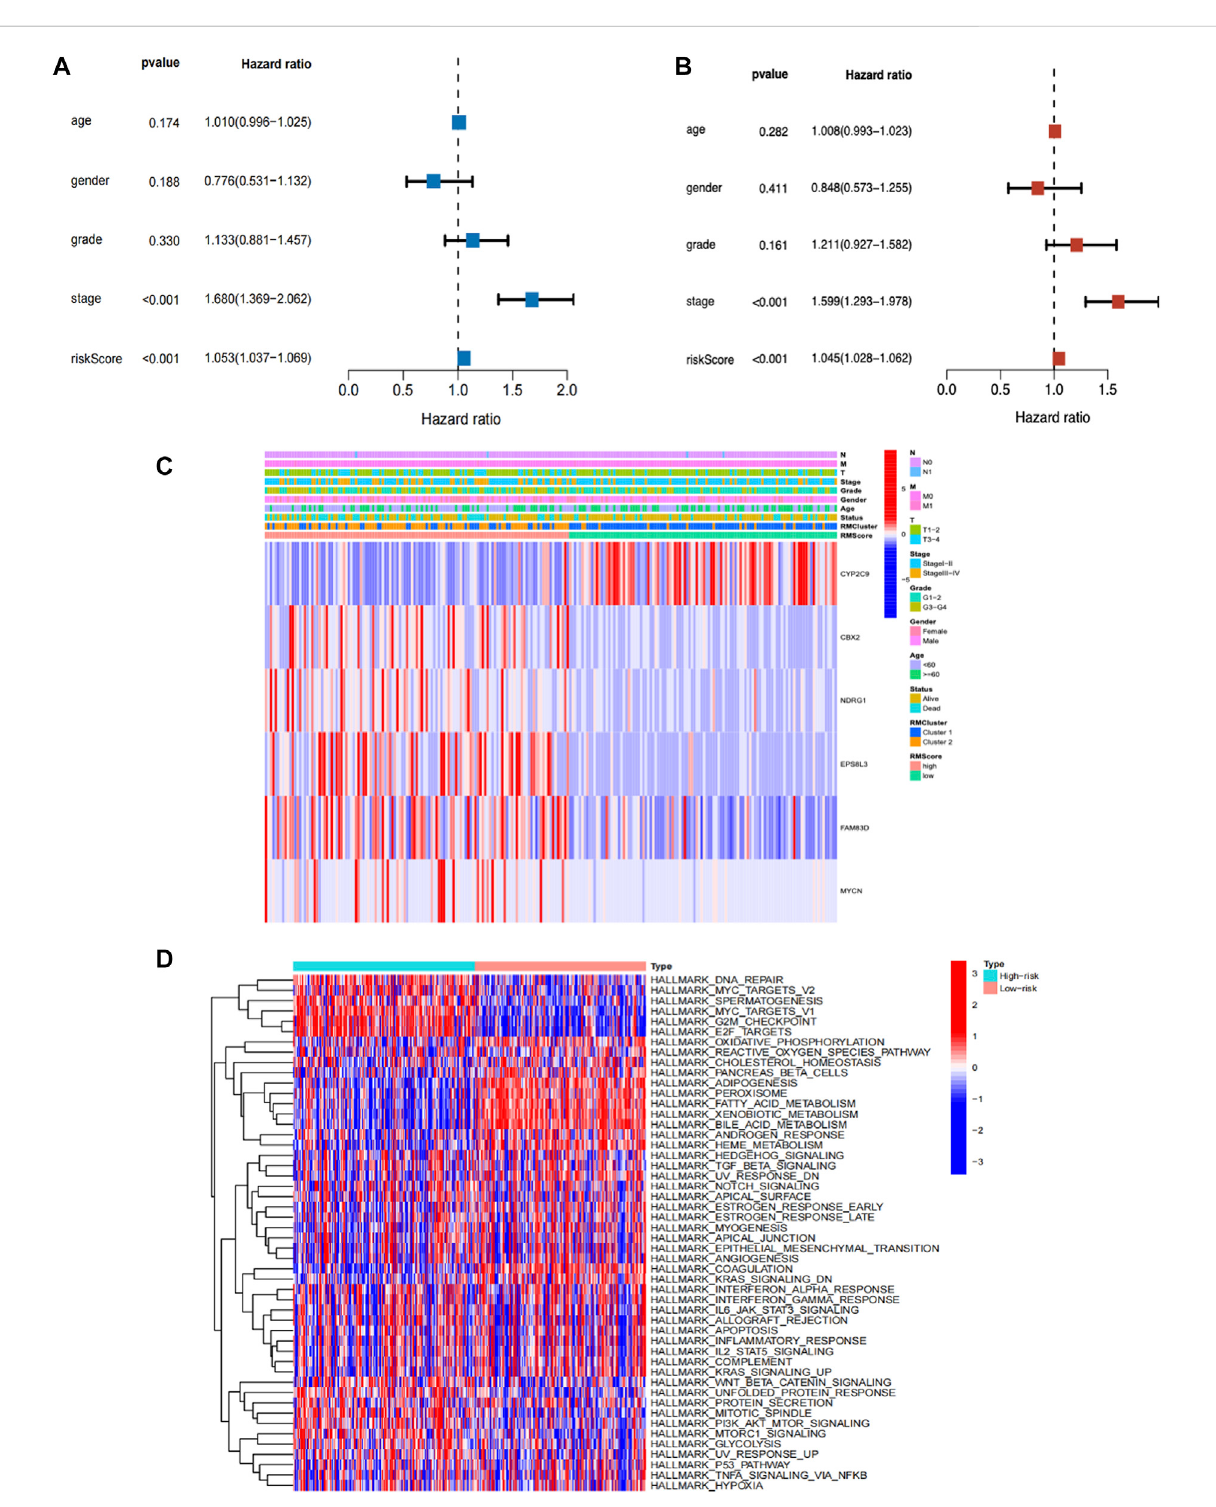
FIGURE 4 (A) Univariate Cox regression analysis and (B) multivariate Cox regression analysis verifying independent prognostic value of RMScore for the prognosis of HCC patients. (C) Heat map for the association of gene and clinicopathologic features with prognosis of HCC patients. (D) Visualization of biological processes analyzed by GSVA in two RMScore